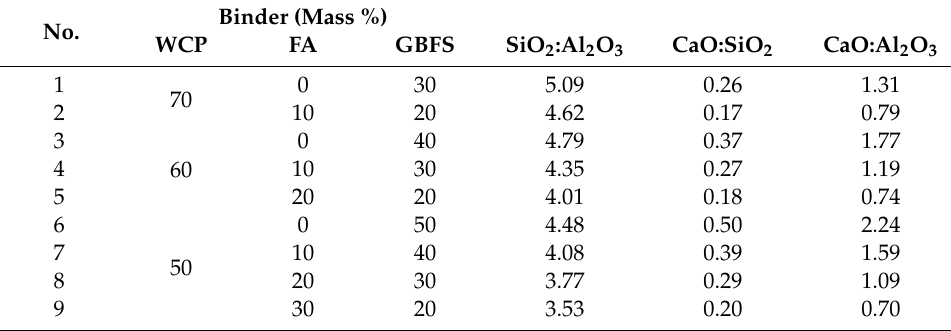
Table 5. Contents of constituents in high volume